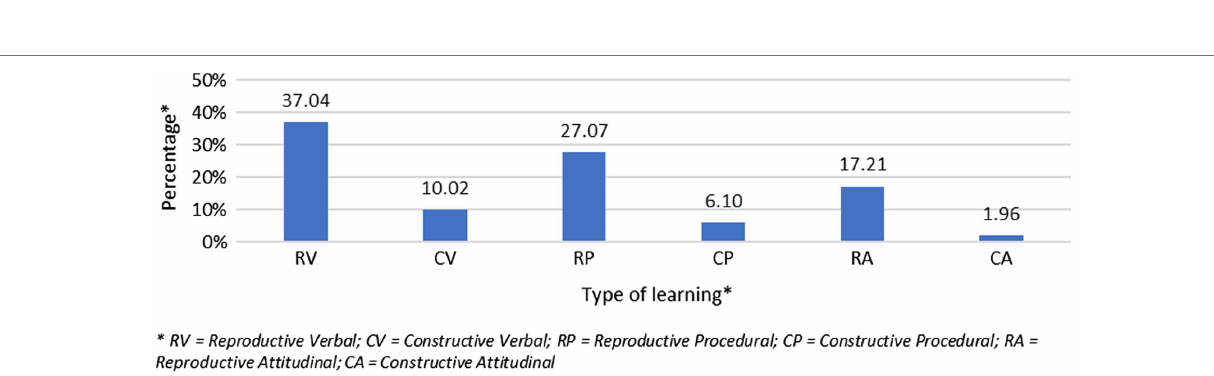
FIGURE 1 | Percentage of goals proposed by the teachers arranged according to type of